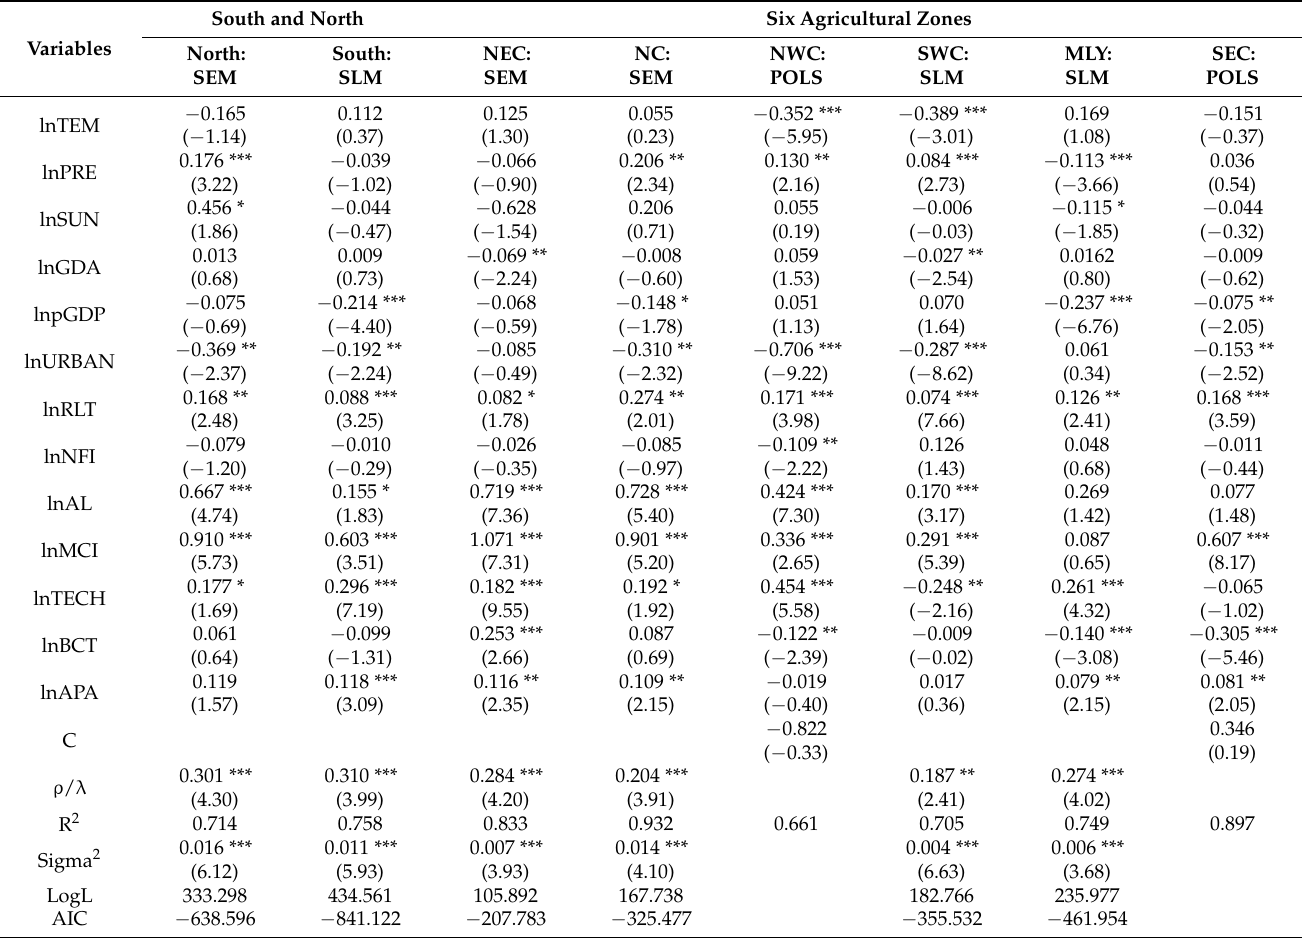
Table 3. Spatial econometric estimates of driving factors in different